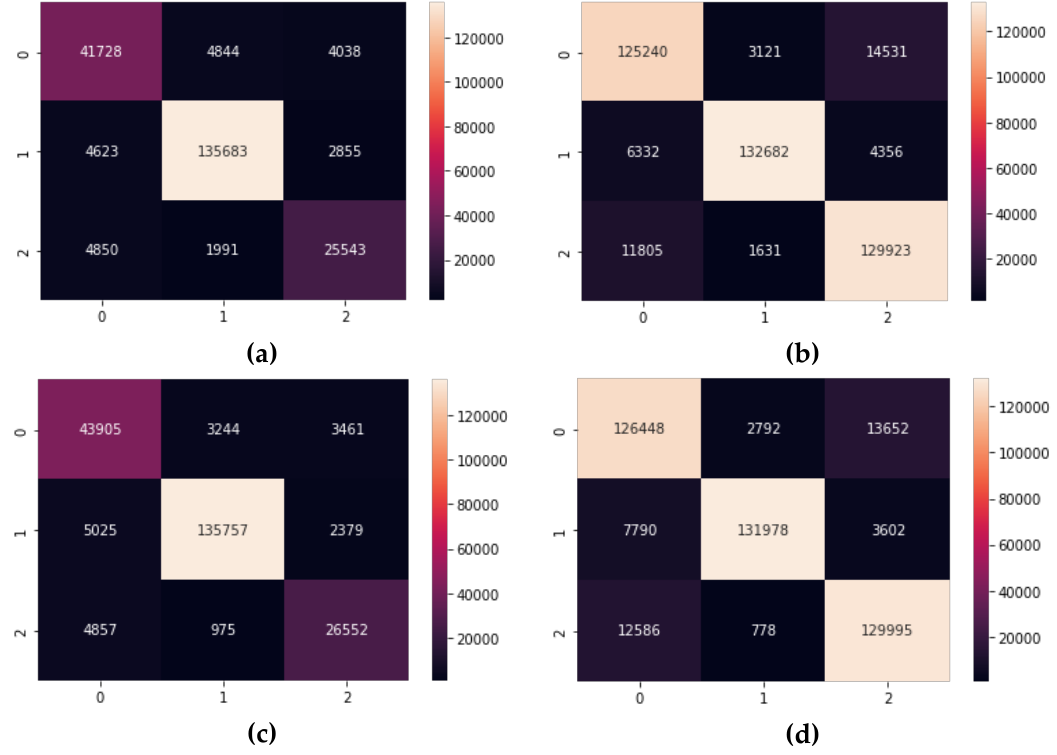
Figure 9. The Confusion Matrices for the Deep Learning algorithms, listed as: (a) DNN in setting 1; (b) DNN in setting 2; (c) LSTM in setting 1; (d) LSTM in setting 2.